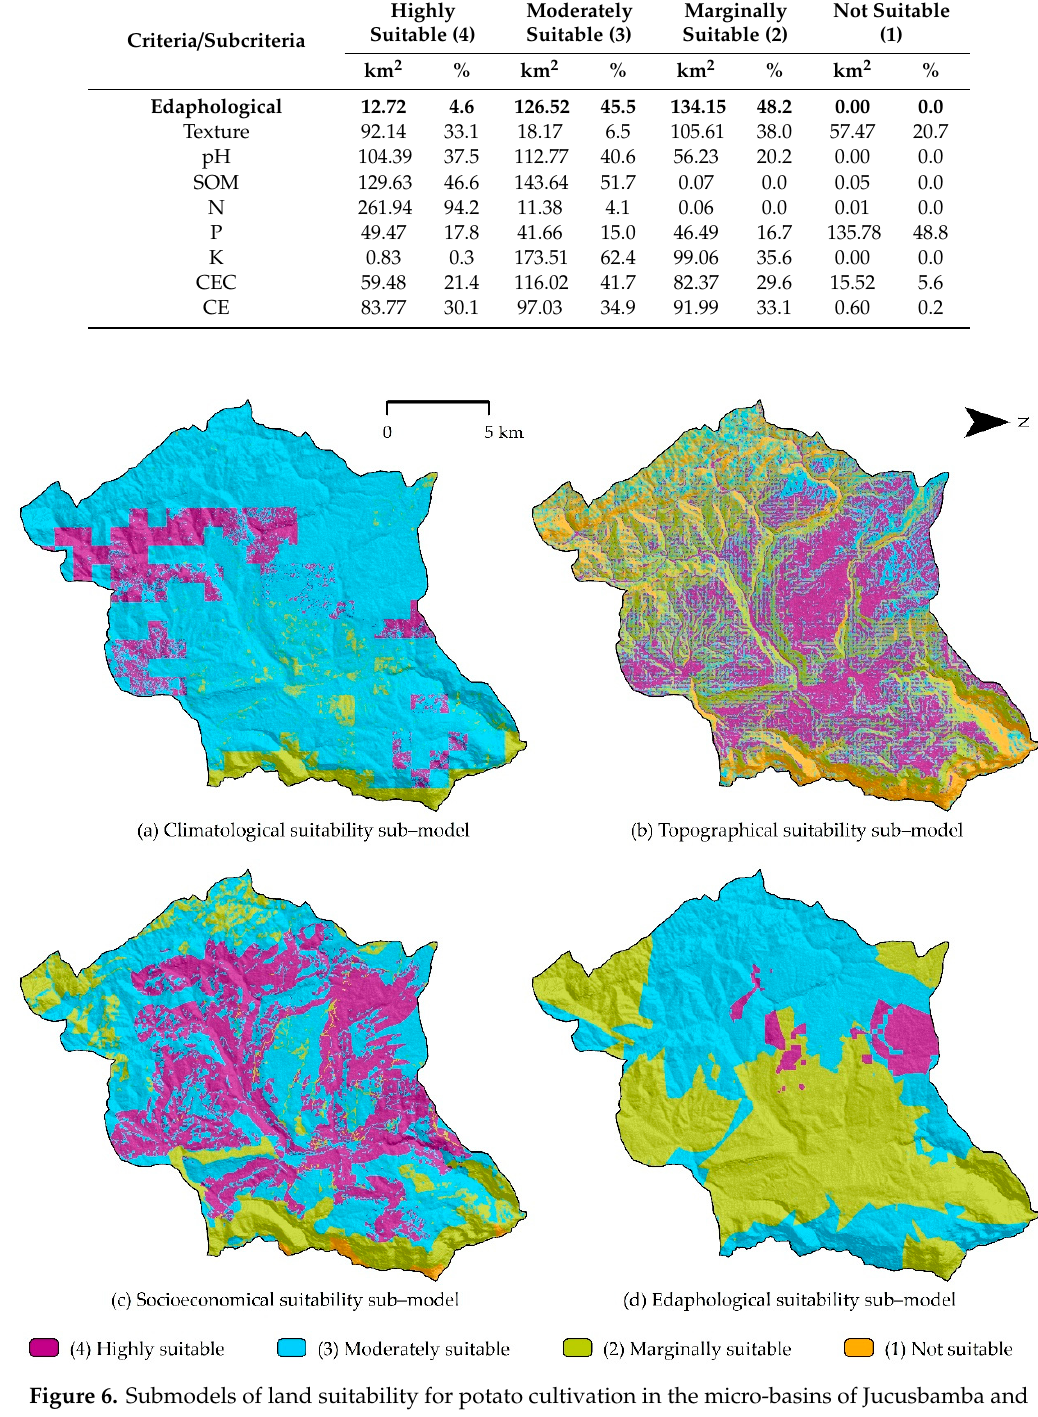
Figure 6. Submodels of land suitability for potato cultivation in the micro-basins of Jucusbamba and Tincas, Amazonas (NW Peru). Table 7. Land suitability according to criteria and subcriteria for potato cultivation in the Jucusbamba and Tincas microwatersheds (NW Peru).